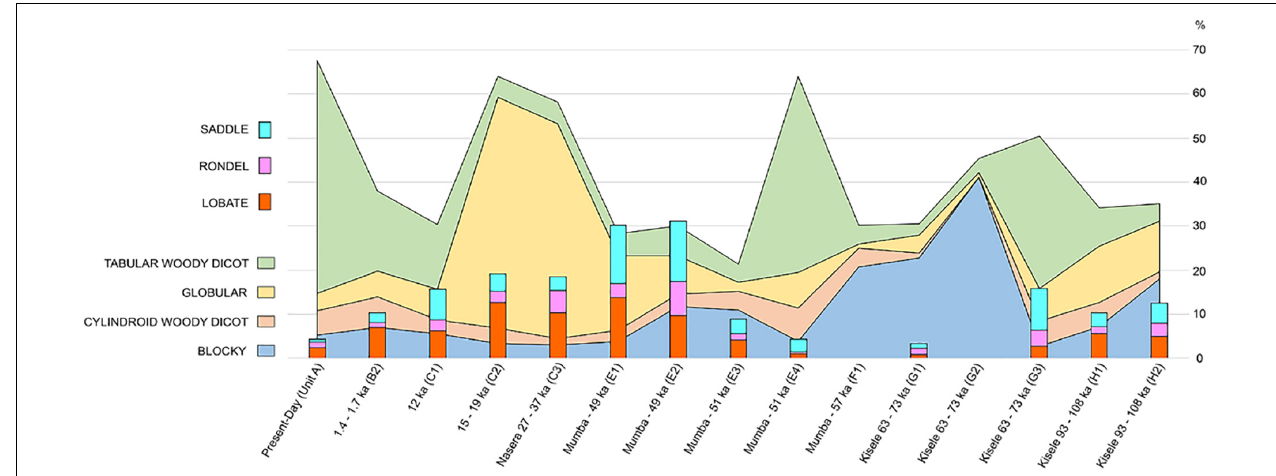
FIGURE 6 | Percent of prominent phytolith classes over